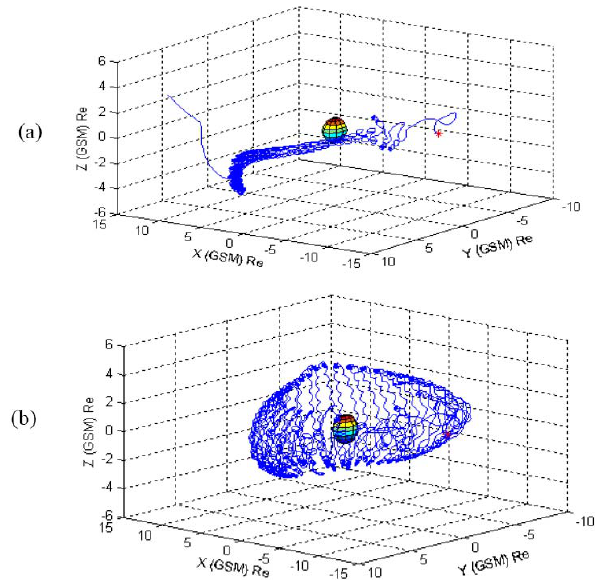
Fig. 10. Injection path of an 20keV O + with equatorial pitch angle of 70 ◦ initially located at x =− 8 R E , y =− 2 R E , and z = 0 in the T96 D st =− 100 magnetic field model. The upper (a) and lower (b) panels represent the cases without and with E s ,